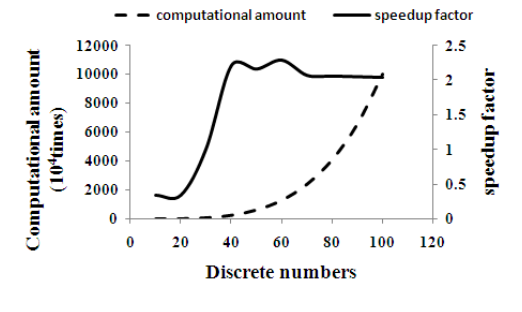
(b) The relationship between speedup ratio and computation scale Fig. 5. Comparison of analog